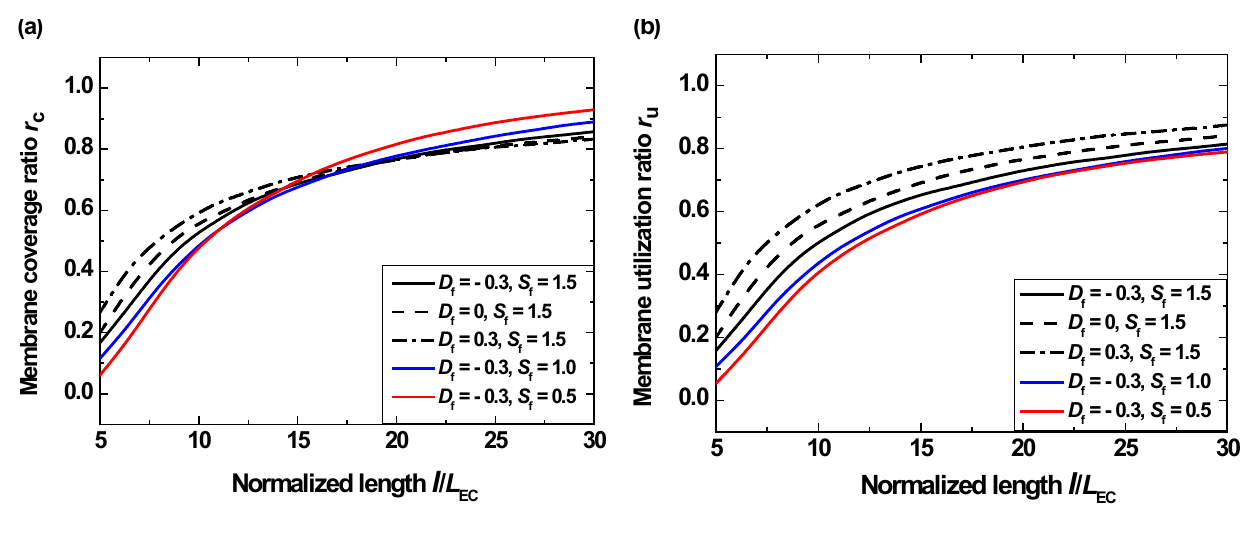
Figure 16. Predicted values of ( a ) the membrane coverage ratio and ( b ) the utilization ratio as a function of the normalized length for different combinations of the deployment factor and the normalized sulcus